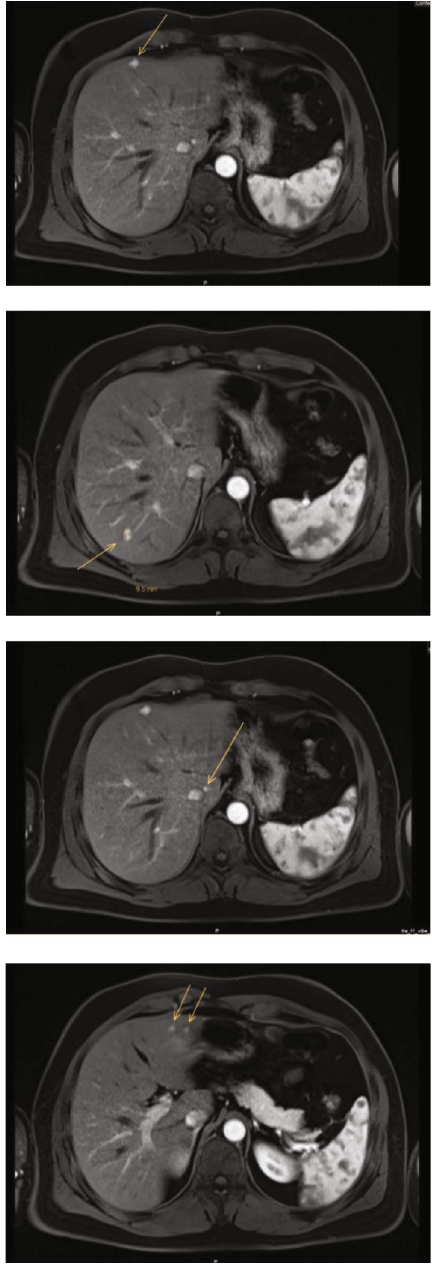
Figure 1: Liver MRI: demonstrates several liver lesions (segments 1, 3, 4, 7). These lesions were new compared to the liver MRI fi ve years ago. One lesion in segment 3 and one lesion in segment 1 were new compared to the MRI scan of one month ago.